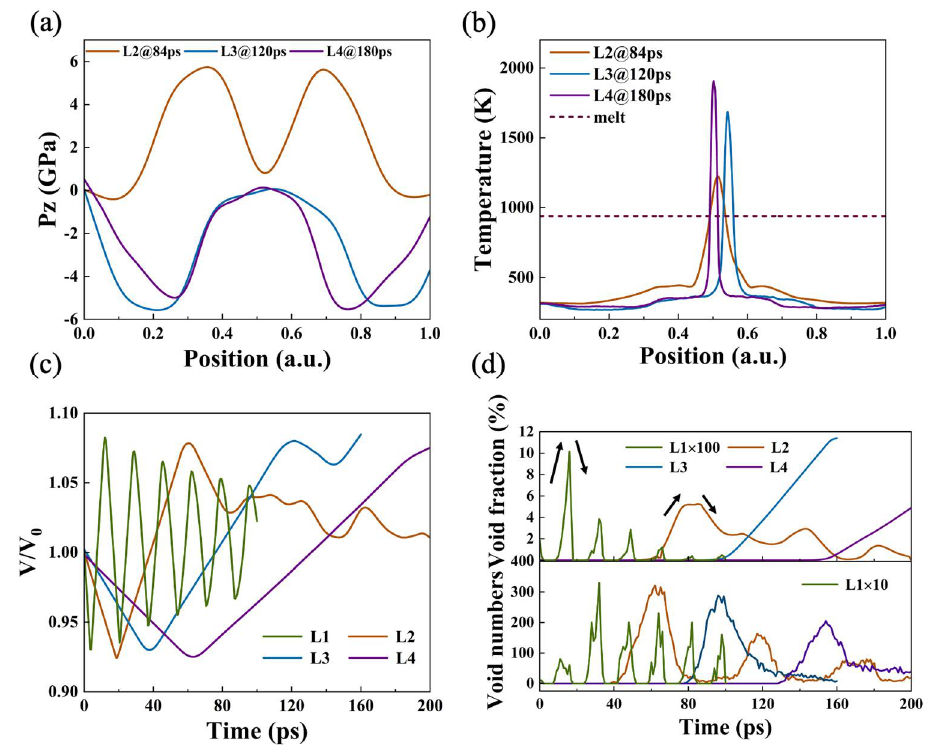
Figure 7. ( a ) Longitudinal stress profile and ( b ) temperature profile of L2, L3, and L4 at 84, 120, and 180 ps, respectively, at v 0 = 0.5 km/s. The red dotted line represents the melting temperature of 940 K for aluminum under the EAM potential. Evolution of ( c ) sample volume and ( d ) void volume fractions and void numbers of L1, L2, L3, and L4.